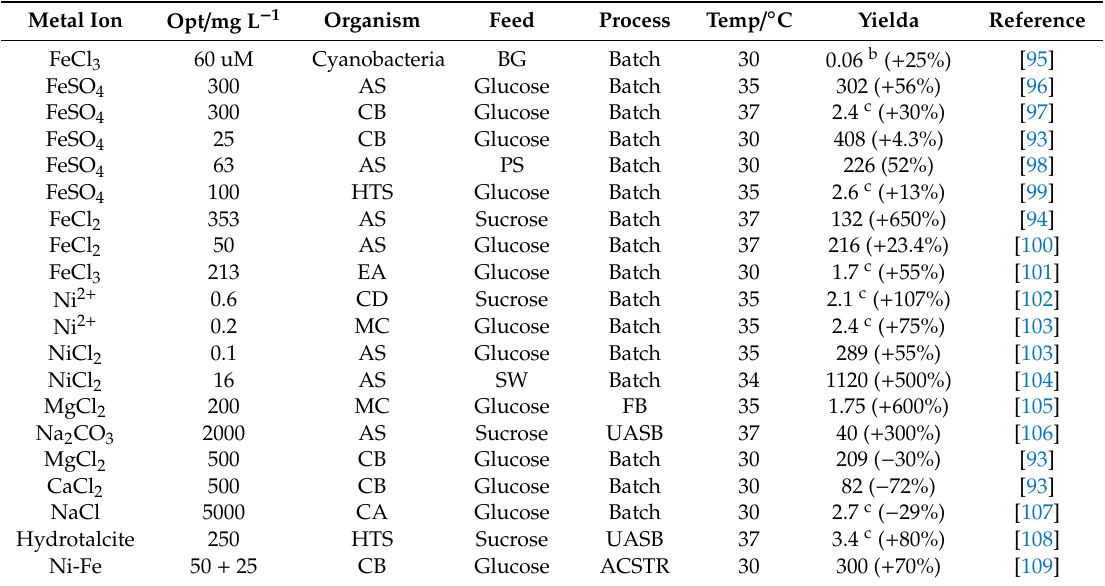
Table 3. Comparisons of bio-hydrogen production with addition of nickel and other metal nanoparticles. Metal Ion